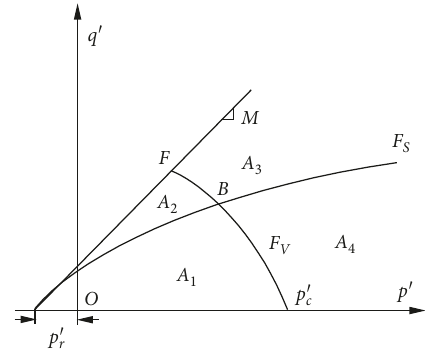
Figure 8: Volume yield surface and shear creep shear yield surface in the p